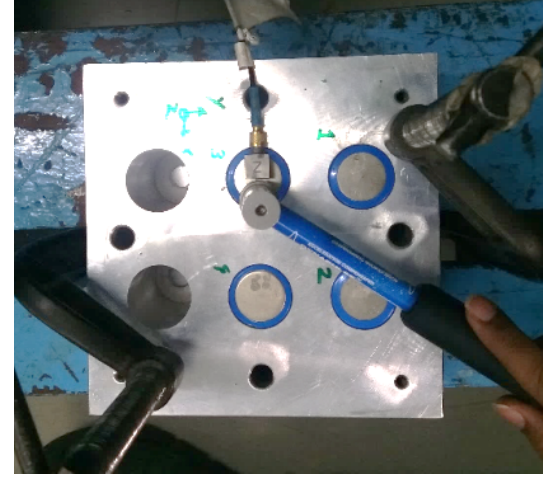
ff ness measurement set Figure 2. Dynamic stiffness measurement set up. Figure 2. Dynamic sti